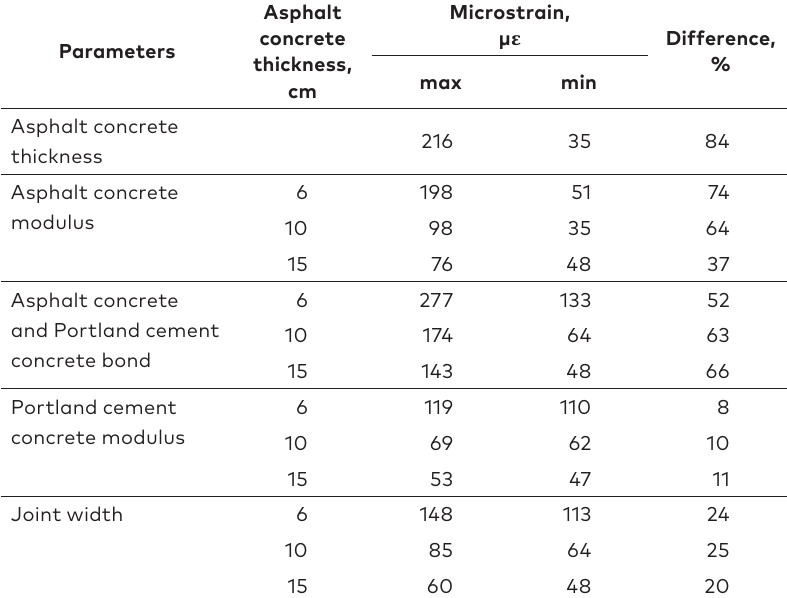
Table 3. Longitudinal tensile strain variation versus pavement